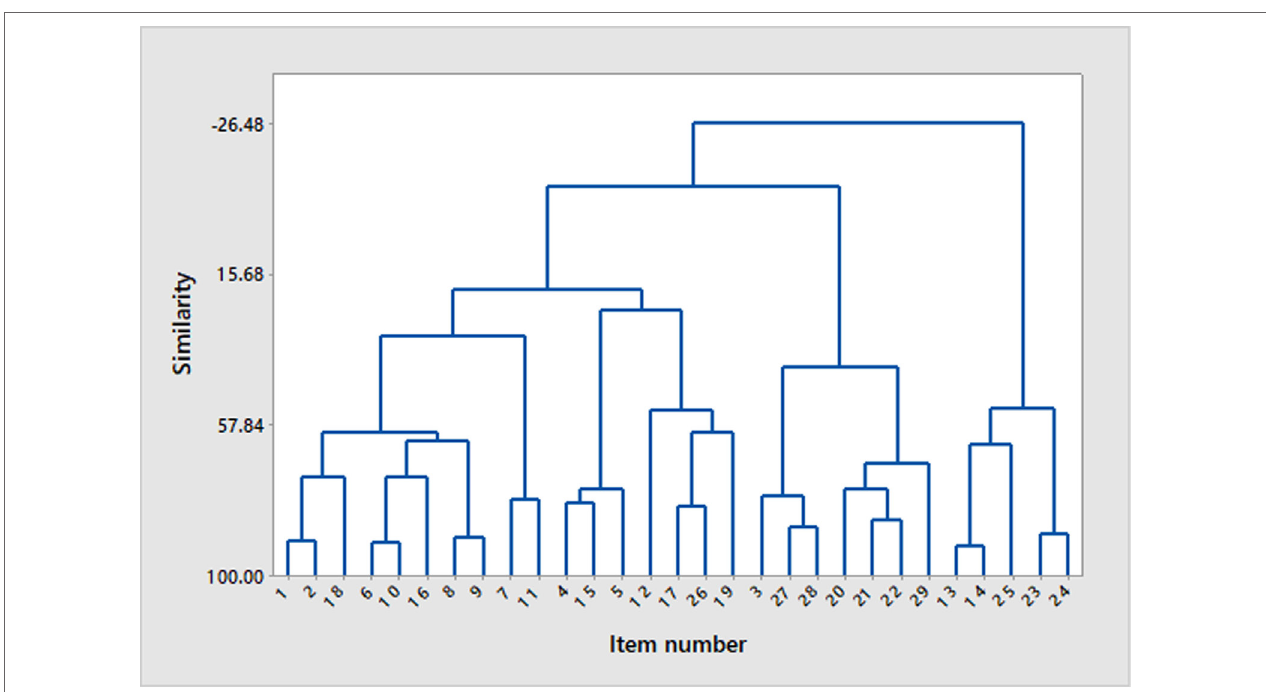
FigUre 1 | Dendrogram showing clustering of survey items on the basis of similarity in response score using Ward’s method of linkage. For details of item content, see Tables 2 and 3